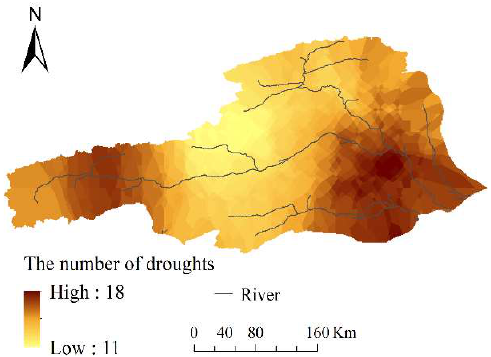
Figure 6. The number of drought years during the period of 1980–2010.